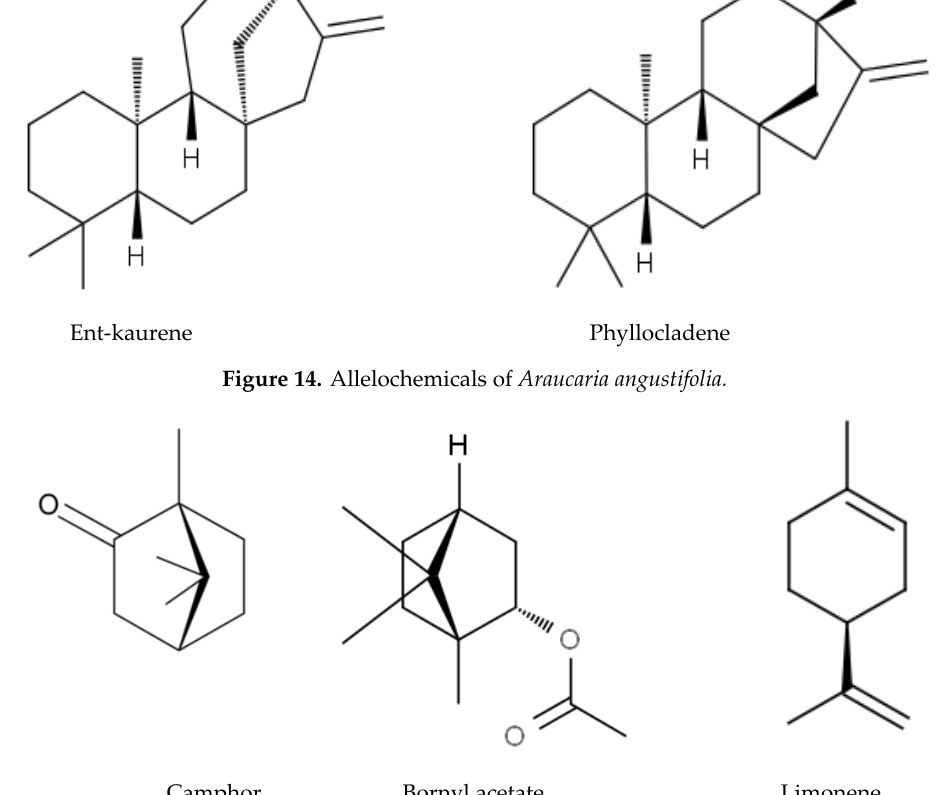
Figure 15. Monoterpens of Juniperus ashei.